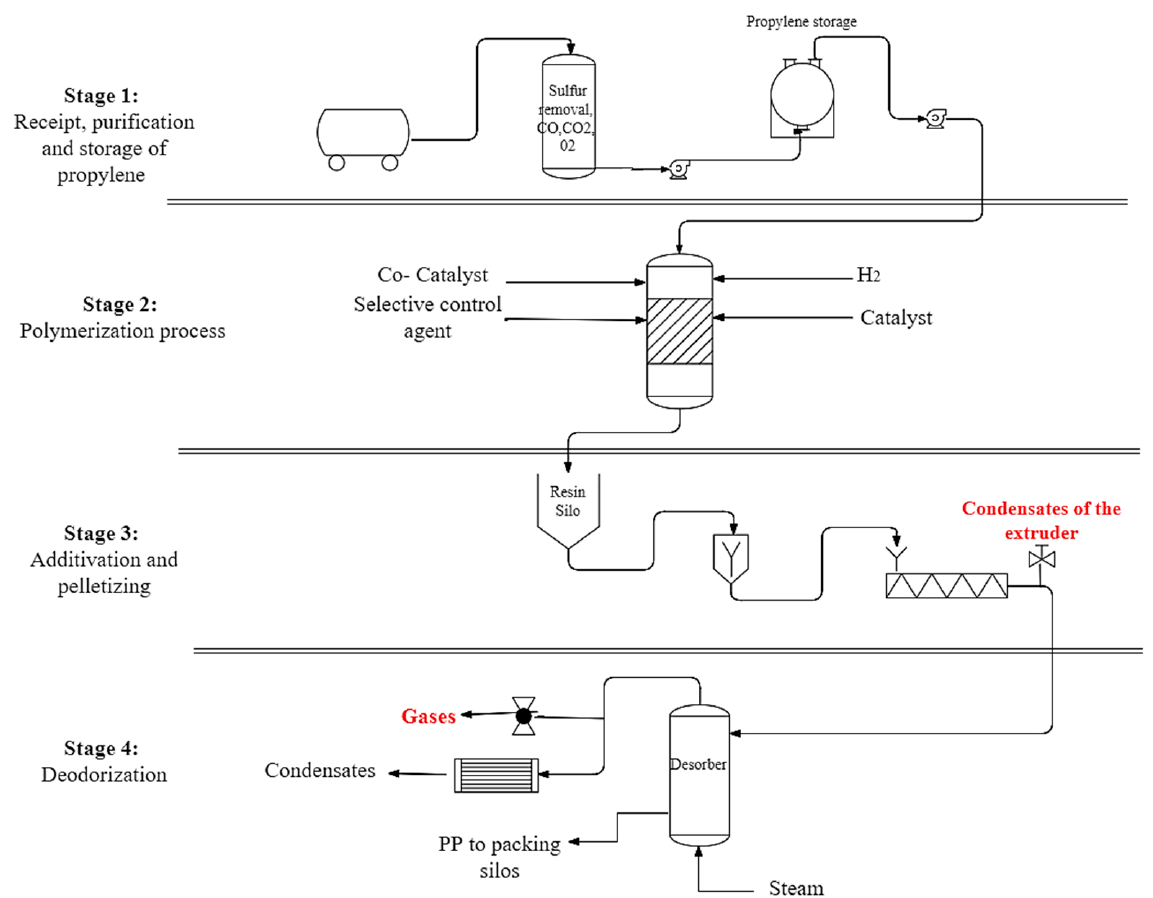
Figure 1. Polypropylene production stages and sampling points.